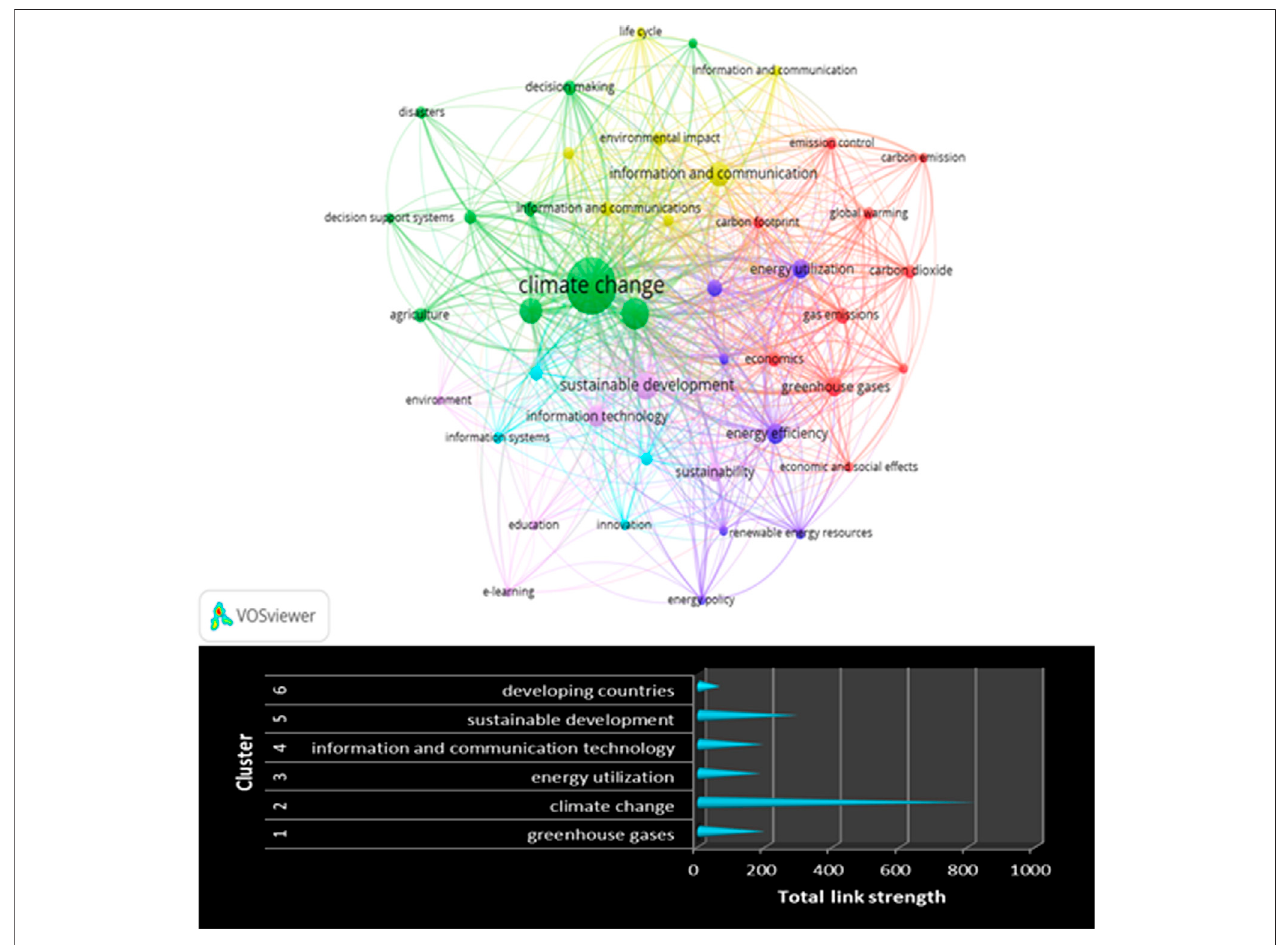
FIGURE 3 | Keyword analysis and total link strength of keywords in each